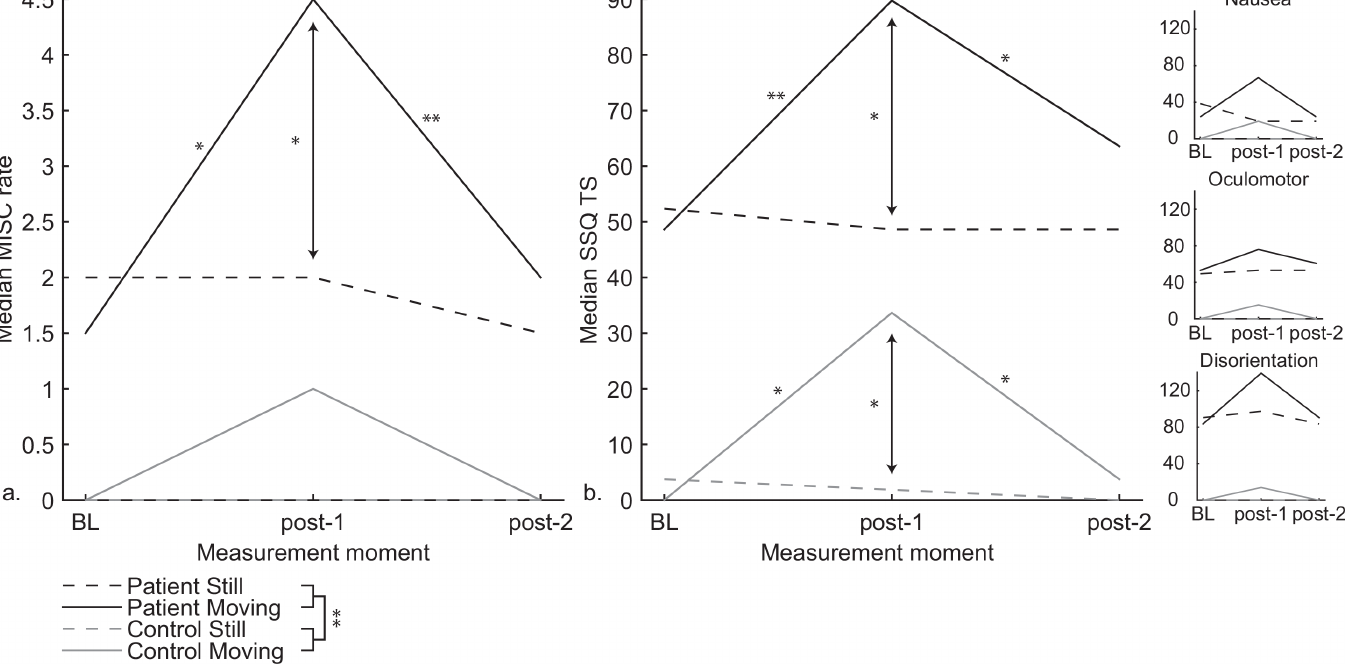
Fig 4. a. Median MISC rate and b. Median SSQ total score (TS) with the symptom cluster scores depicted in the inset. VVM patients always reported more severe symptoms than controls. Both VVM patients and controls reported an increase in symptom severity due to exposure to optokinetic stimulation. Significant differences at p < . 05 and p < . 01 are indicated with * and ** ,